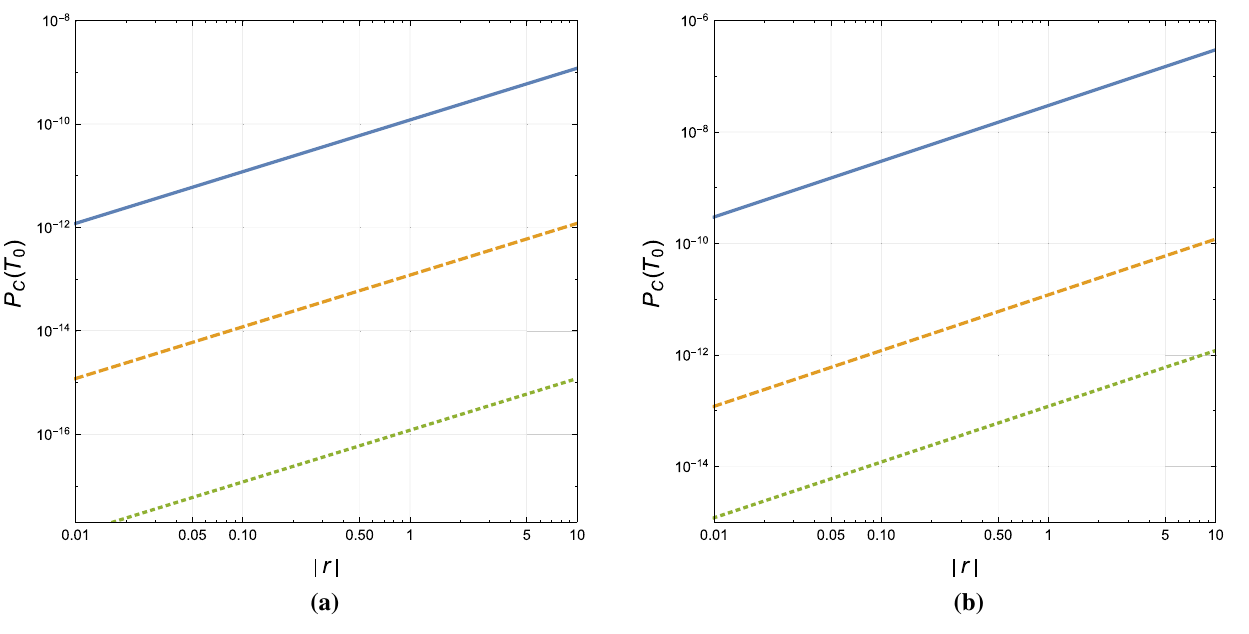
function of | r | (where r ≡ U i / Q i ) at the CMB frequency ν 0 = 10 9 Hz for magnetic field amplitudes B e 0 = 8 × 10 − 8 G (continuous line), B e 0 = 10 − 8 G (dashed line) and B e 0 = 10 − 9 (dotted line) are shown. In both plots we used a value of | Q i | = 10 − 6 . For simplicity we showed also the grid lines in